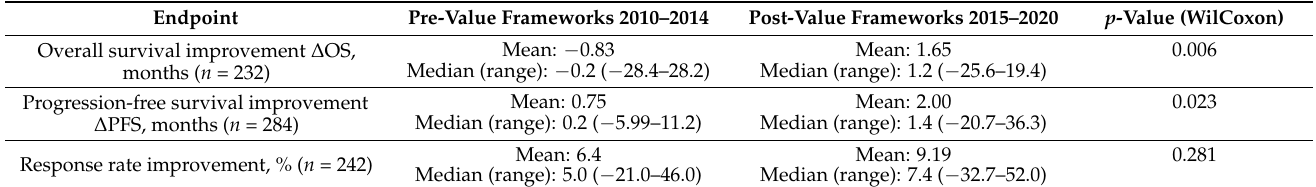
Table 2. Univariate analysis of changes in clinical endpoints in the pre- and post-value frameworks eras. Endpoint Pre-Value Frameworks 2010–2014 p -Value